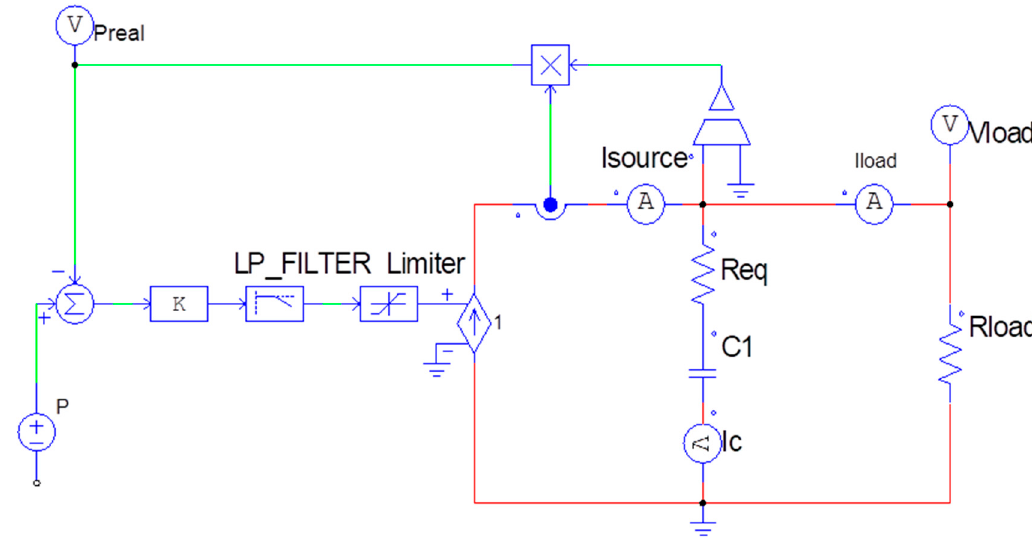
Figure 2. Simulating PSIM scheme for representation transient process in R-(RC) circuit.